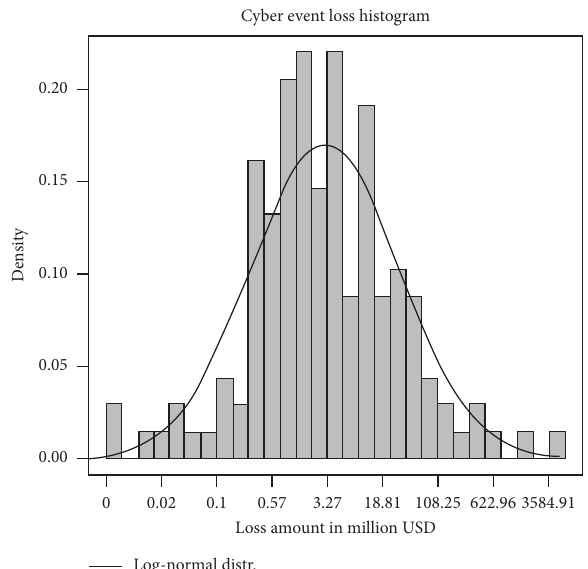
Figure 10: Histogram of actual loss amount and its assumed